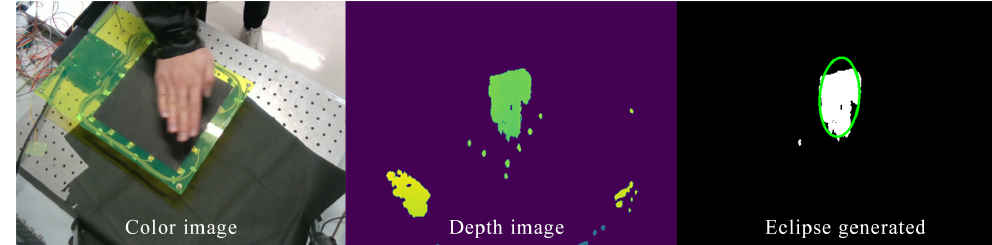
Figure 11. Hand position recognition process using depth